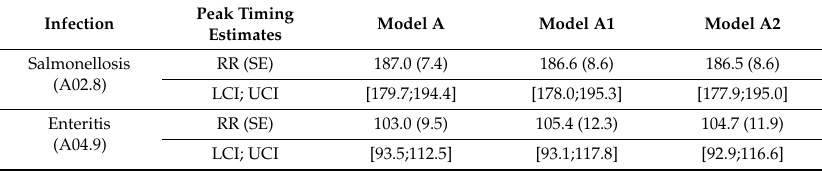
Table 6. Sensitivity analysis of peak timing estimates based on harmonic regression models for health outcomes. Infection Model A